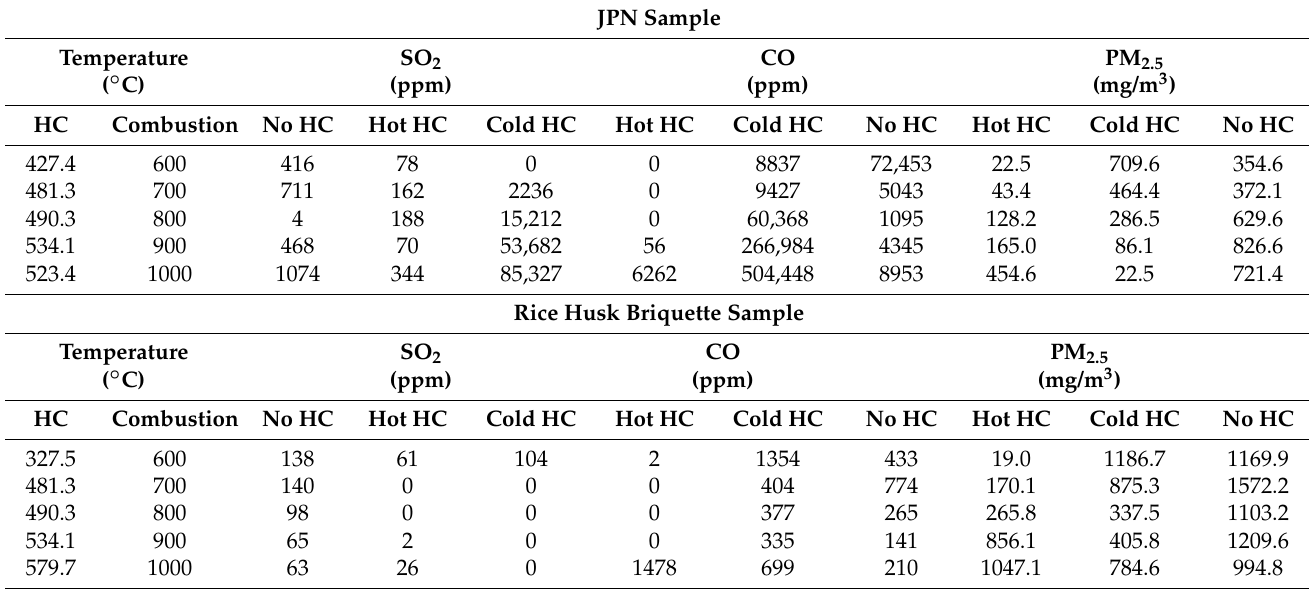
Table 5. Emission pattern of JPN and RB samples versus catalyst